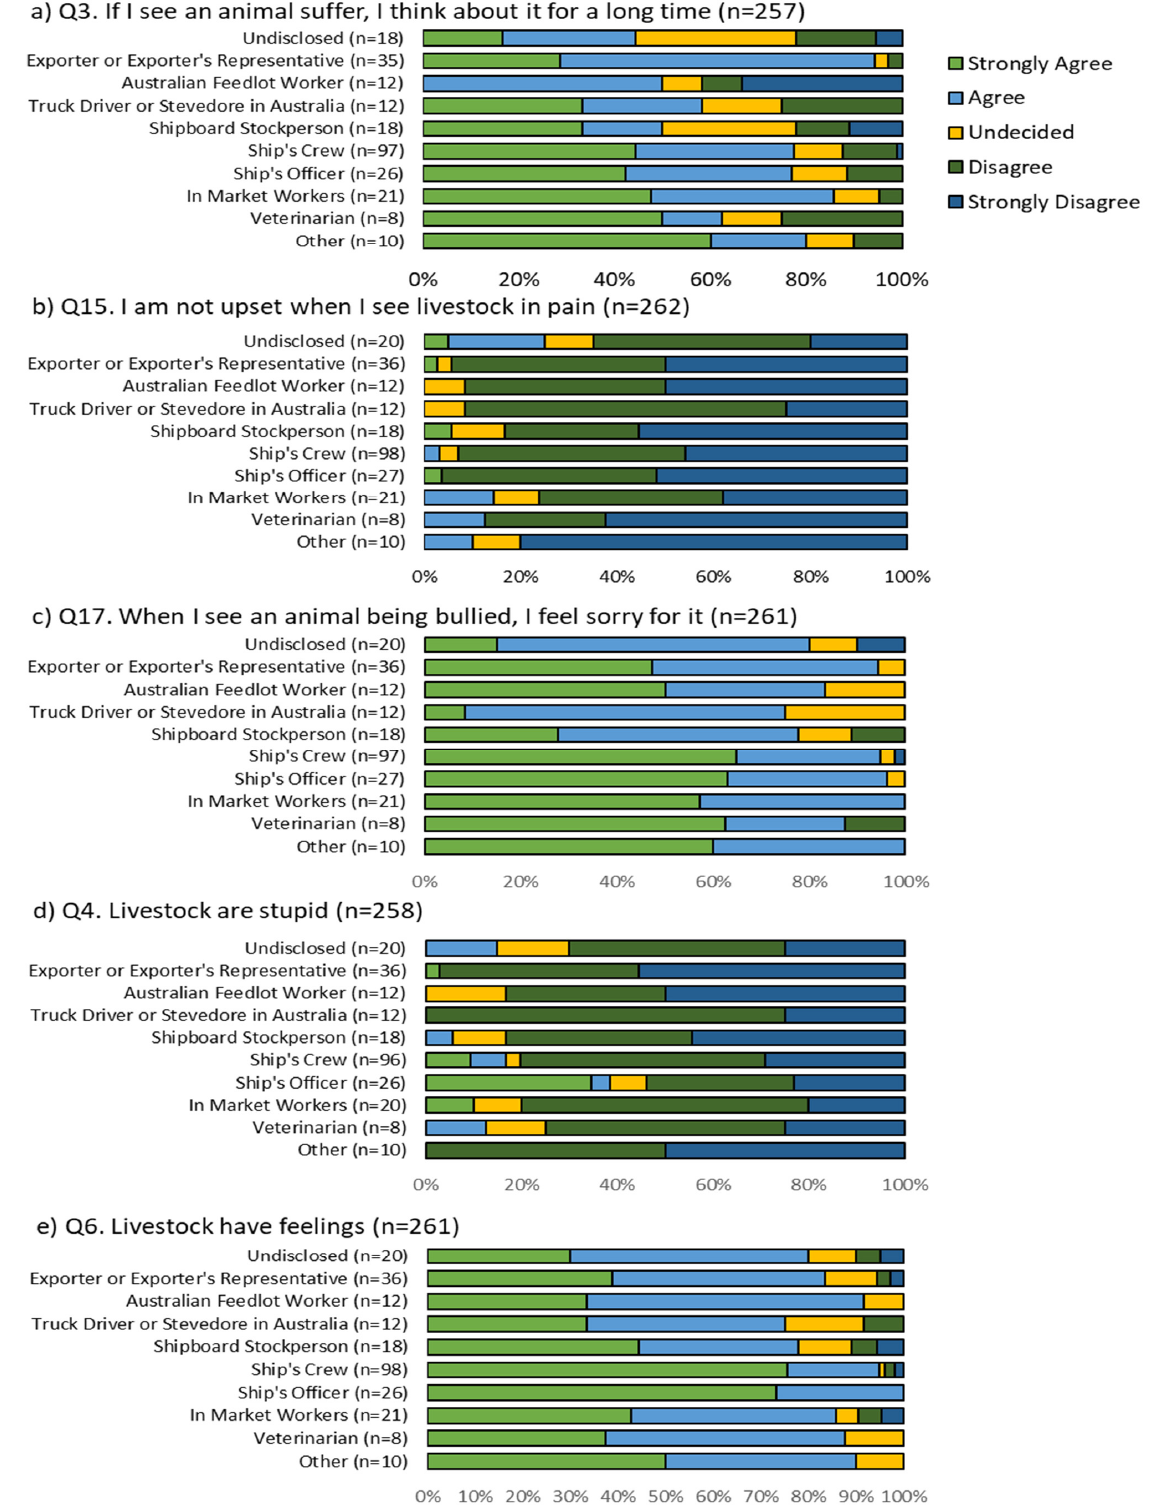
Commented [M2]: Please replace Figure 2. Please note that the subtitles can only appear a), b), c)...cannot be used Figure 2 a)…